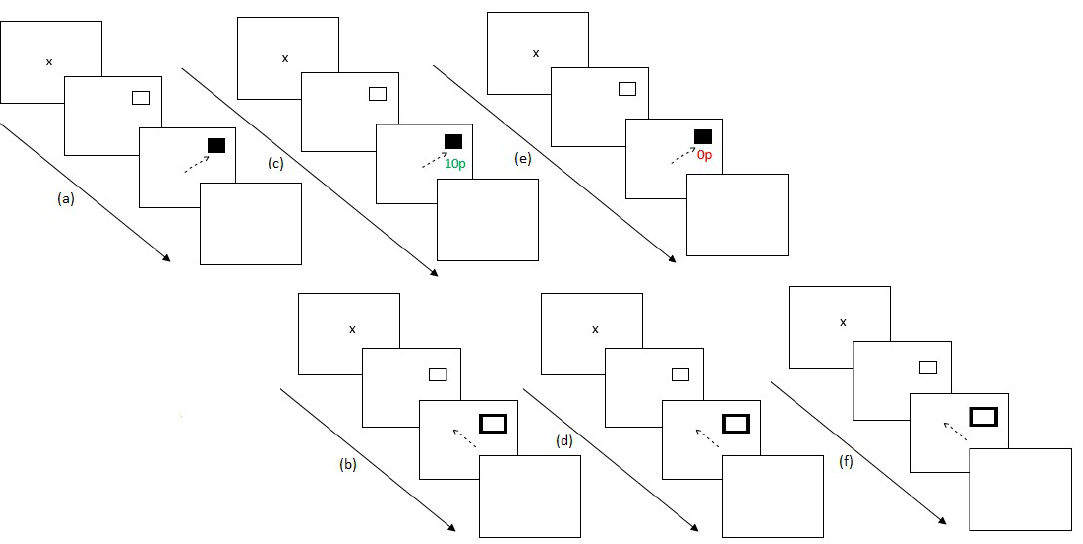
Figure 4. Experimental procedure for Experiment 2. ( a ) After assessing for eye dominance and a 9-point calibration procedure, participants completed two baseline blocks of the reward paradigm where no reward feedback was displayed. ( b ) Participants then completed six blocks of the antisaccade task, ( c ) followed by 10 conditioning blocks of the reward paradigm where only one hemifield was rewarded at a 60% schedule. ( d ) Participants then switched tasks again, completing six blocks of the remote distractor task. ( e ) A further six blocks of the reward paradigm were completed where no reward was given to participants for saccades. ( f ) Finally, participants completed six blocks of the remote distractor task and the experiment ended.